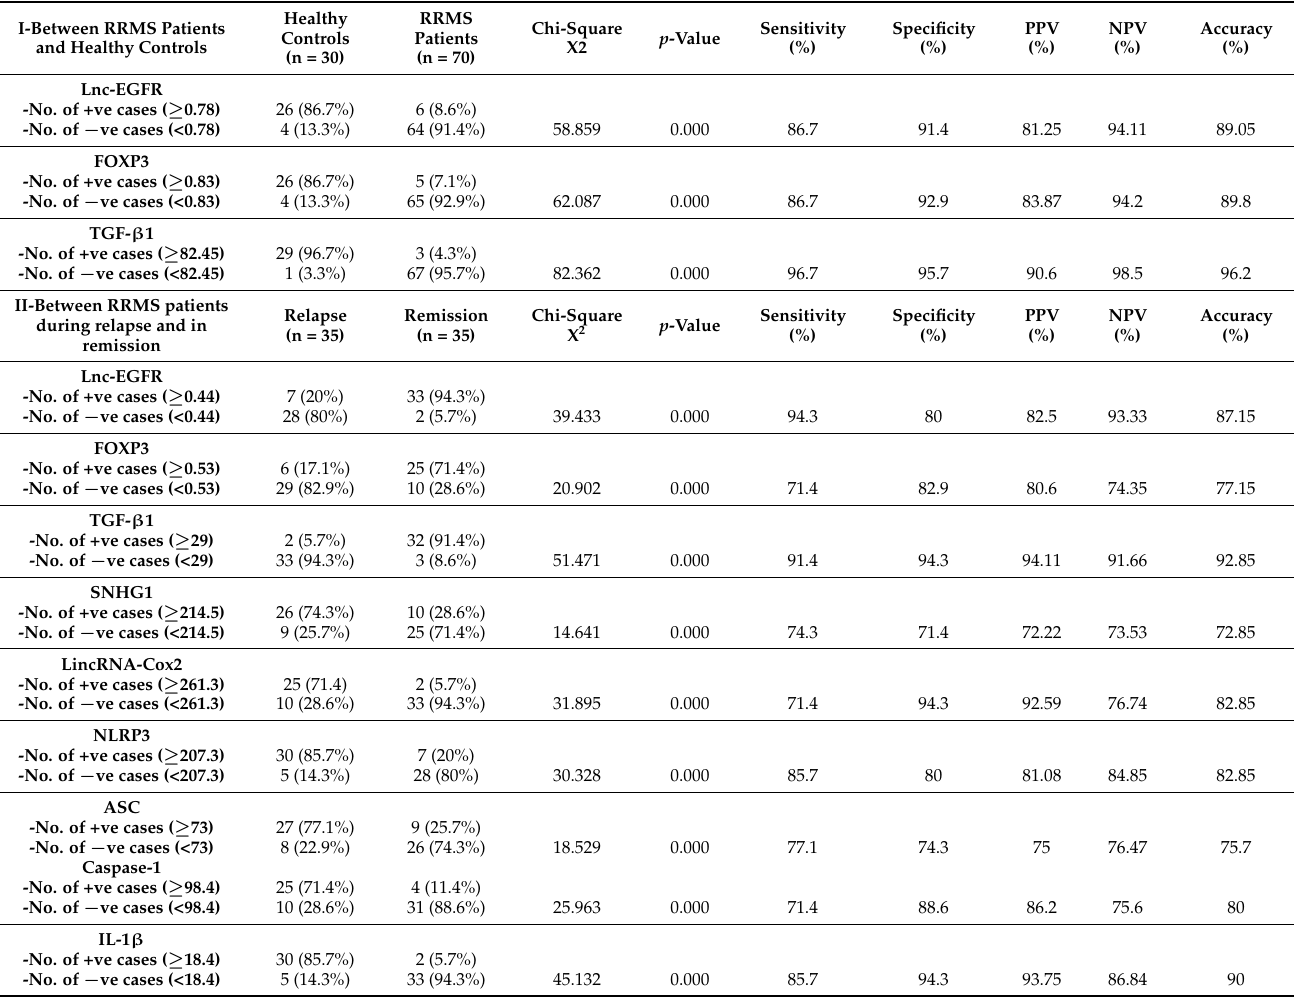
Table 3. Positivity rates of the studied biomarkers and overall sensitivity, specificity, PPV, NPV, and